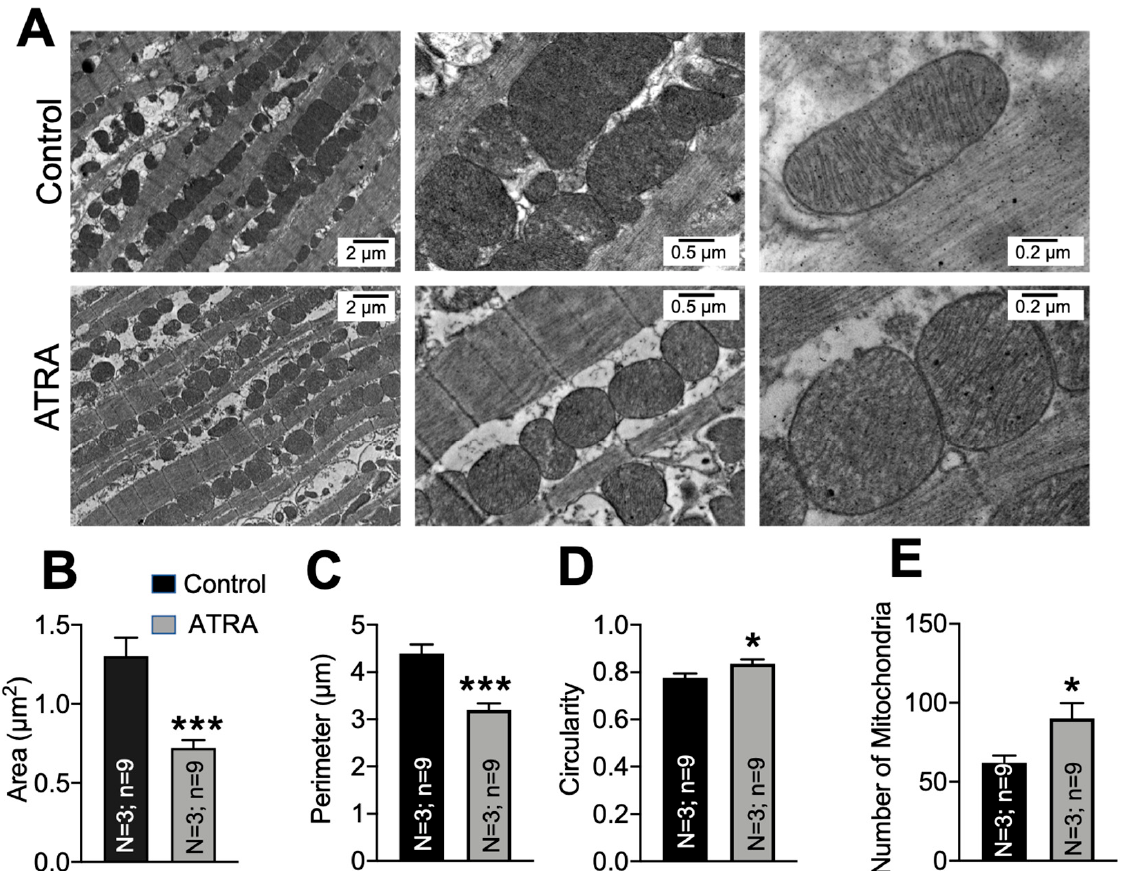
Figure 4. Effects of ATRA on mitochondrial ultrastructure in mice treated with ATRA versus control. ( A ) Representative electron micrographs from ATRA- and corn oil- (vehicle) treated mice at 10,000 × , 25,000 × , and 50,000 × magnification. Mitochondrial ( B ), average area ( C ), perimeter and ( D ) circularity, and ( E ) number of mitochondria per area. Mitochondrial area and perimeter were significantly decreased ( B , C ) and mitochondria were more circular in the ATRA-treated group ( D ) (* p < 0.05, *** p < 0.001, vs. vehicle; unpaired 2-sample t -test). n = 3 hearts; n = 9 micrographs each